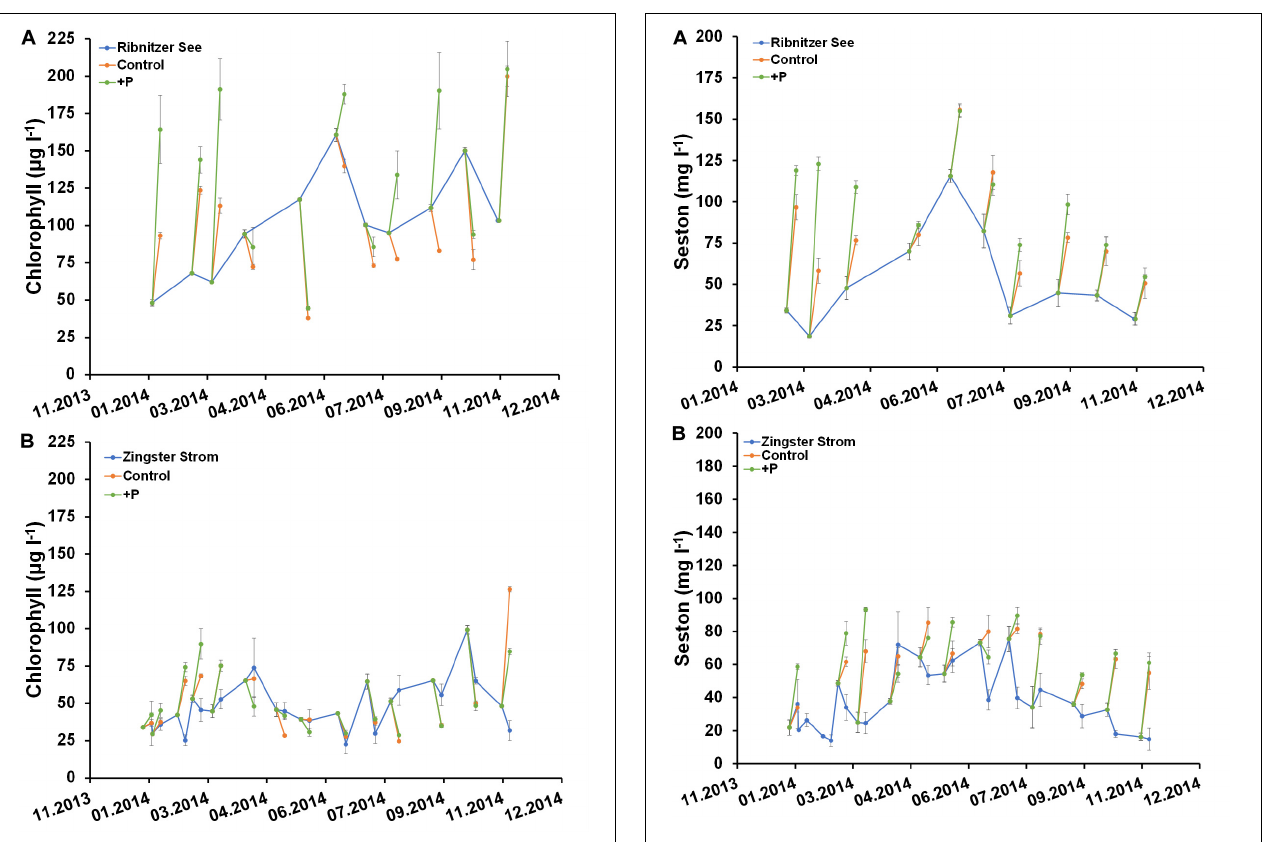
FIGURE 6 | Comparison of Chlorophyll a concentration ( µ g l − 1 ) in unfertilized (control) and fertilized (+P) samples after 7 days and the actual ecosystem (Ribnitzer See and Zingster Strom) in 2014. Samples were fertilized with a 10 µ mol l − 1 DIP pulse (final concentration) at day 0. Treatments with waters of the Ribnitzer See (A) and Zingster Strom (B) were filtrated after 7 days of incubation. Additionally, Chlorophyll-values from the actual ecosystem (only Zingster Strom) were included as weekly average. Incubation in batch tanks at 15 ◦ C ( ± 1 ◦ C), photon flux 100 µ mol photons m − 2 s − 1 , light:dark 16:8 h. Error bars in A and B are calculated as standard deviation ( n = 3).